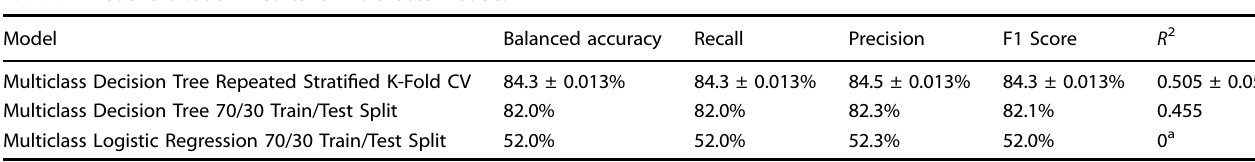
Table 2. Model evaluation metrics for multi-class